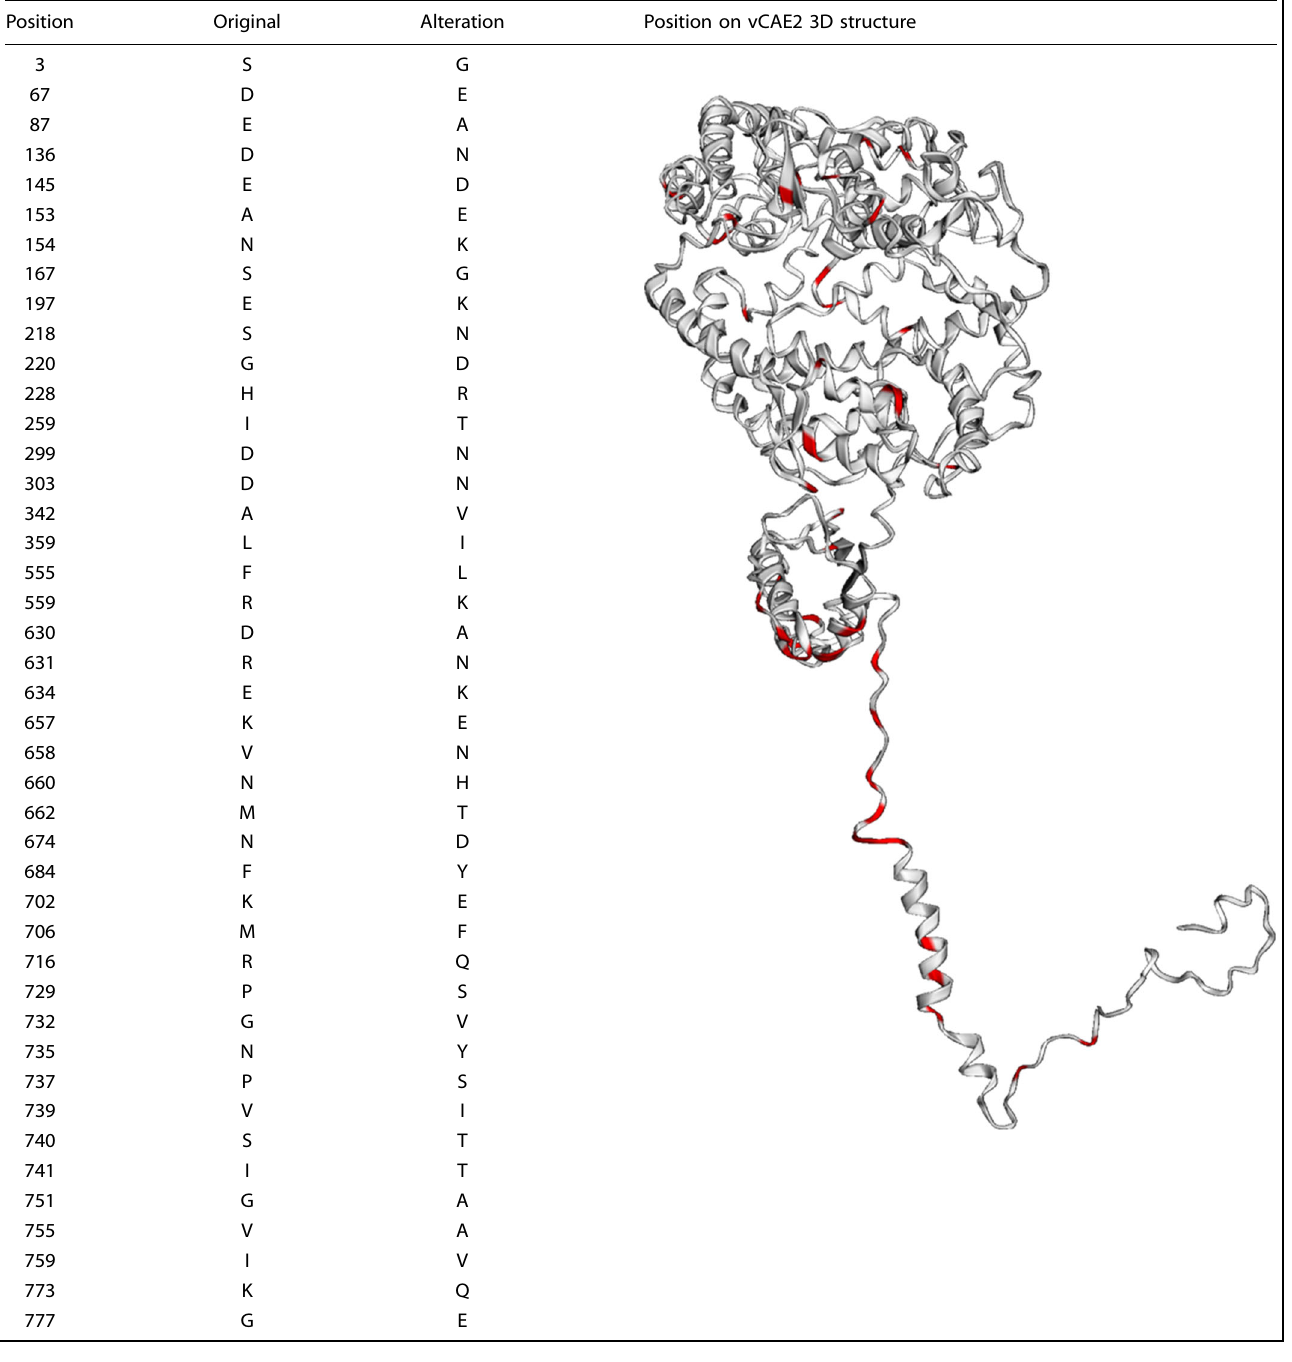
Table 4. Residues mutations between vACE2(alteration) and hACE2(original) and mutations positions on vACE2 3D structure(red). Position Original Alteration Position on vCAE2 3D